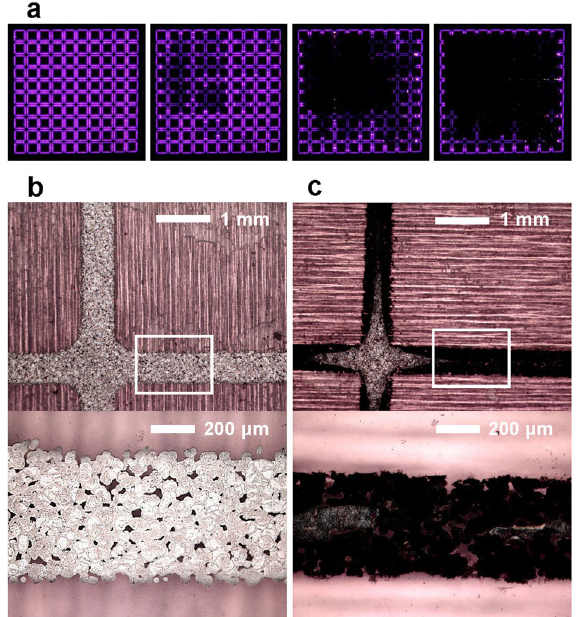
Figure 2. ( a ) Degradation of plasma emissions from FXDBD with a 5 kVpp sinusoidal voltage at 3 kHz. The time interval between images is 1 min. Note that the plasma in the leftmost image is shown 3 min after the operation began. Microscope-obtained photographs of an inkjet-printed electrode on ( b ) unused and ( c ) used FXDBD sheets, respectively. The bottom images show magnified photographs of the upper images, with the corresponding areas indicated by the white